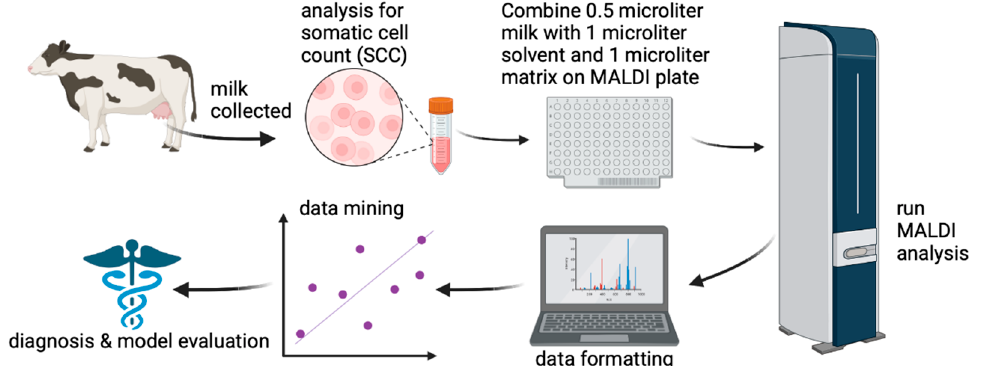
Figure 1 . Overview of project work flow. Figure 1. Overview of project work